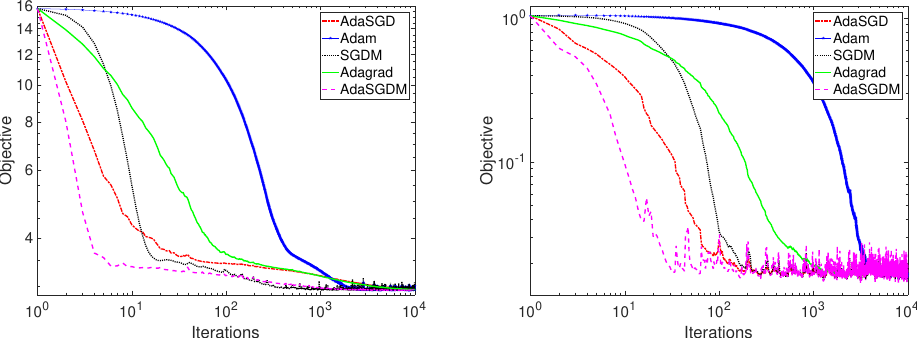
Figure 1. The convergence paths of the algorithms SGDM, Adam, and Adagrad and the proposed methods AdaSGD and AdaSGDM when m = 60, n = 10, and the objective functions are smooth convex functions. Left : the objective function f 1 ( x ) ; Right : the objective function f 2 ( x ) .